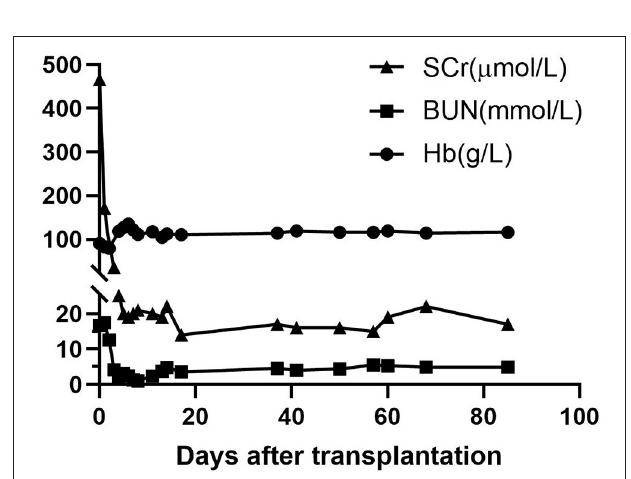
by the cumulative side effects of consecutively administering sodium nitroprusside to lower his blood pressure. He recovered